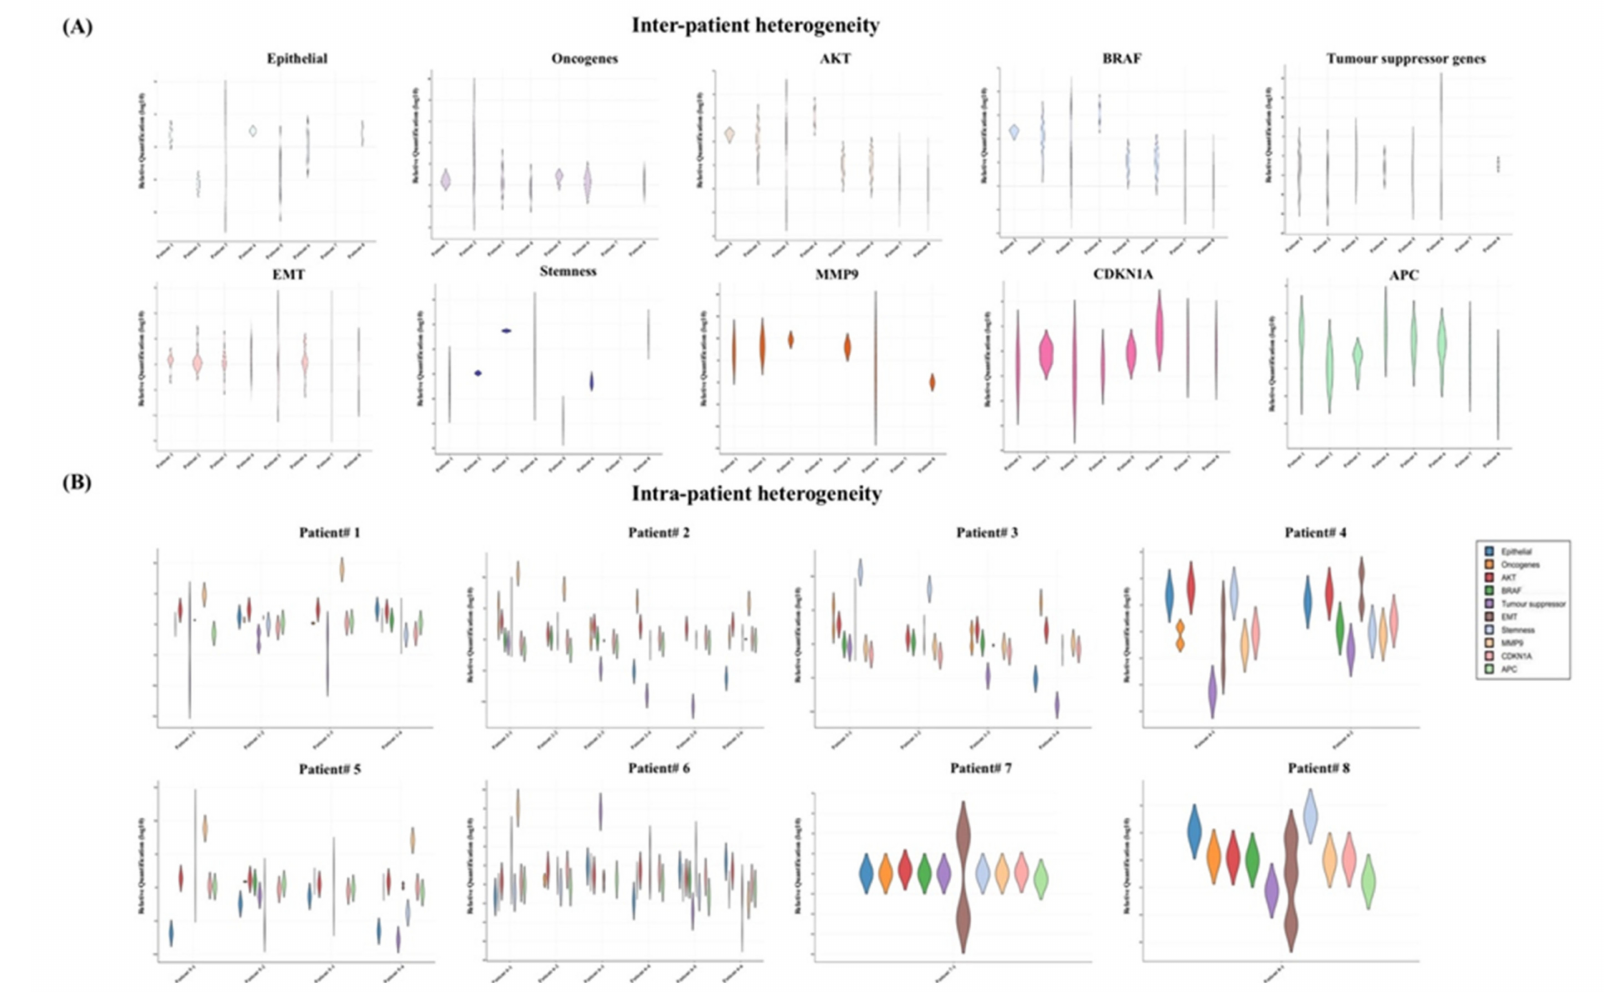
Figure 4. Gene expression heterogeneities of the single CTCs in di ff erent patients and in the same patient. Violin plot of the gene expression profiles in the single CTCs showed heterogeneities ( A ) in di ff erent patients and ( B ) in the same